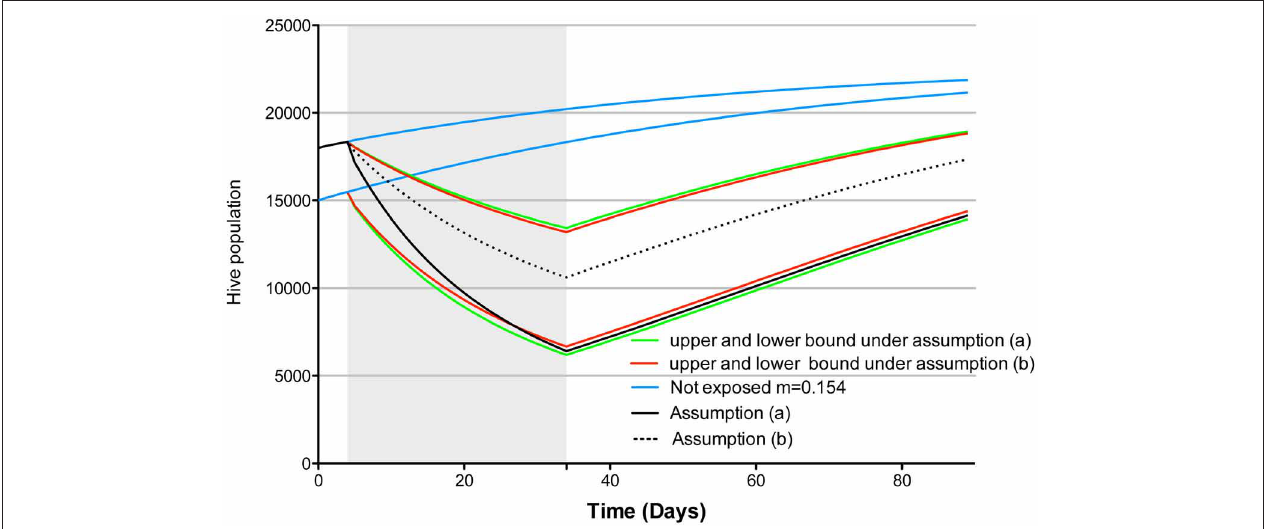
FIGURE 1 | Simulation of the Khoury et al. (2011) population dynamic model as implemented by Cresswell and Thompson (2012) 2 , model parameters were w = 27 . 000, L = 2000, α = 0 . 25, σ = 0 . 75 [as per Henry et al. (2012)], starting hive population was 18,000 (lower bound) or 15,000 (upper bound), pesticide exposure condition assumed the extreme case of 100% foragers exposed. The shaded area corresponds to the exposure period. In blue the projected population growth under a non